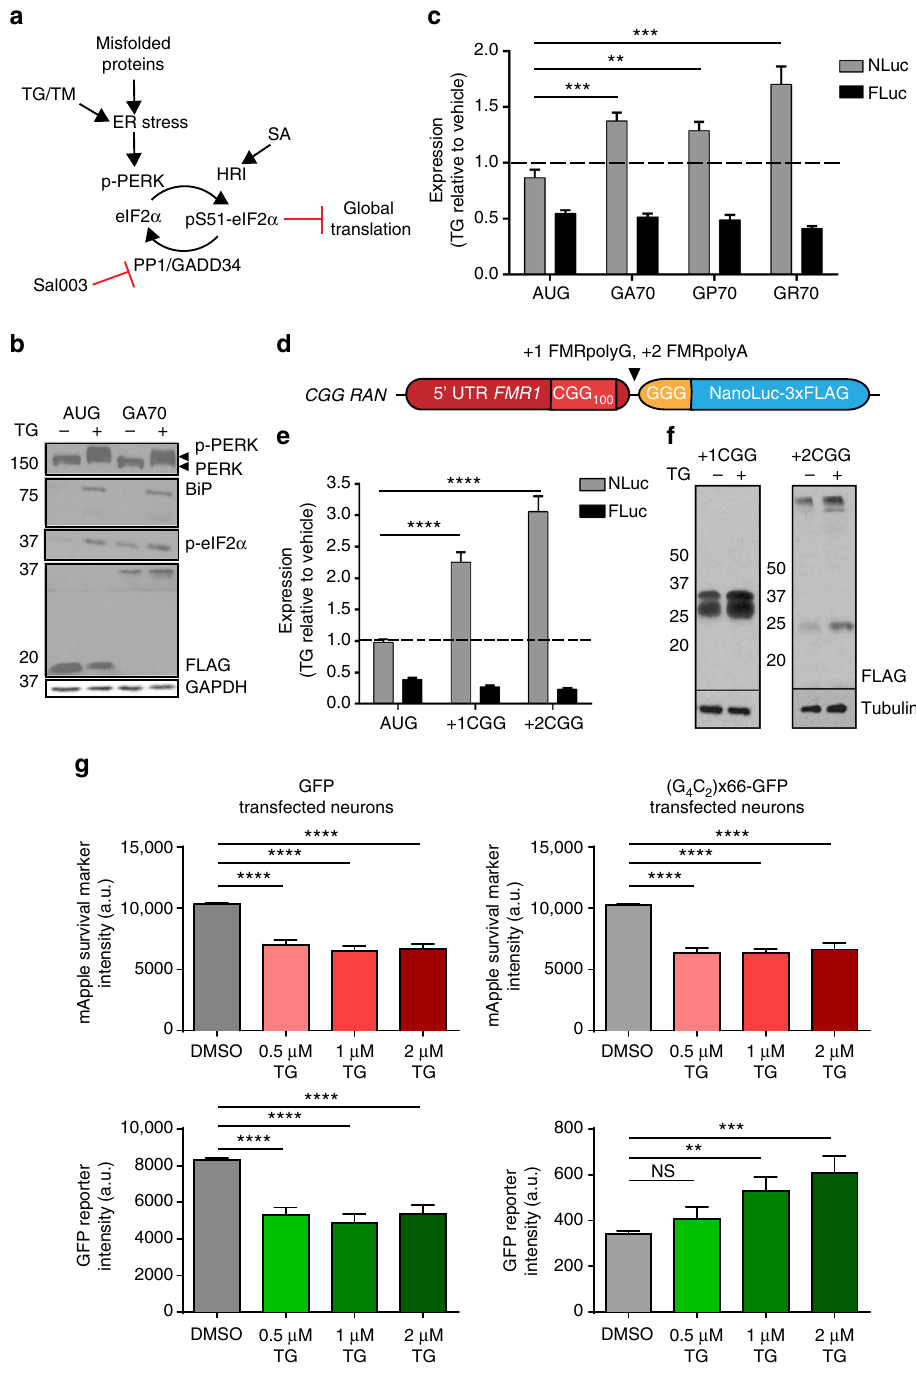
Fig. 3 RAN translation is selectively activated by the integrated stress response. a Schematic of the integrated stress response pathway. b Western blot analysis of the ER stress pathway and C9RAN reporter levels in HEK293 cells after treatment with 2 μ M TG. GAPDH was used as a loading control. c Expression of control and C9RAN NLuc reporters and co-transfected FLuc in HEK293 cells treated with 2 μ M TG, n = 9. d Schematic of the previously published 36 +1 and +2 CGG RAN translation NLuc reporters. e , f Expression of control and CGG RAN translation reporters and co-transfected FLuc in HEK293T cells treated with 2 μ M TG analyzed by ( e ) luciferase activity, n = 9, and ( f ) anti-FLAG western blot. Tubulin was used as a loading control. g Fluorescence intensity of mApple and co-transfected GFP (left) or (G 4 C 2 )×66-GFP (right) in primary rat cortical neurons, imaged with automated fl uorescent microscopy 3 days after treatment with 0.5, 1, or 2 μ M TG, n > 30. Graphs represent mean ± SEM. Two-tailed Student ’ s t test with Bonferroni and Welch ’ s correction, ∗∗ p < 0.01; ∗∗∗ p < 0.001; ∗∗∗∗ p < 0.0001. PERK endoplasmic reticulum ER-resident kinase, HRI heme-regulated inhibitor kinase, SA sodium arsenite, TG thapsigargin, TM